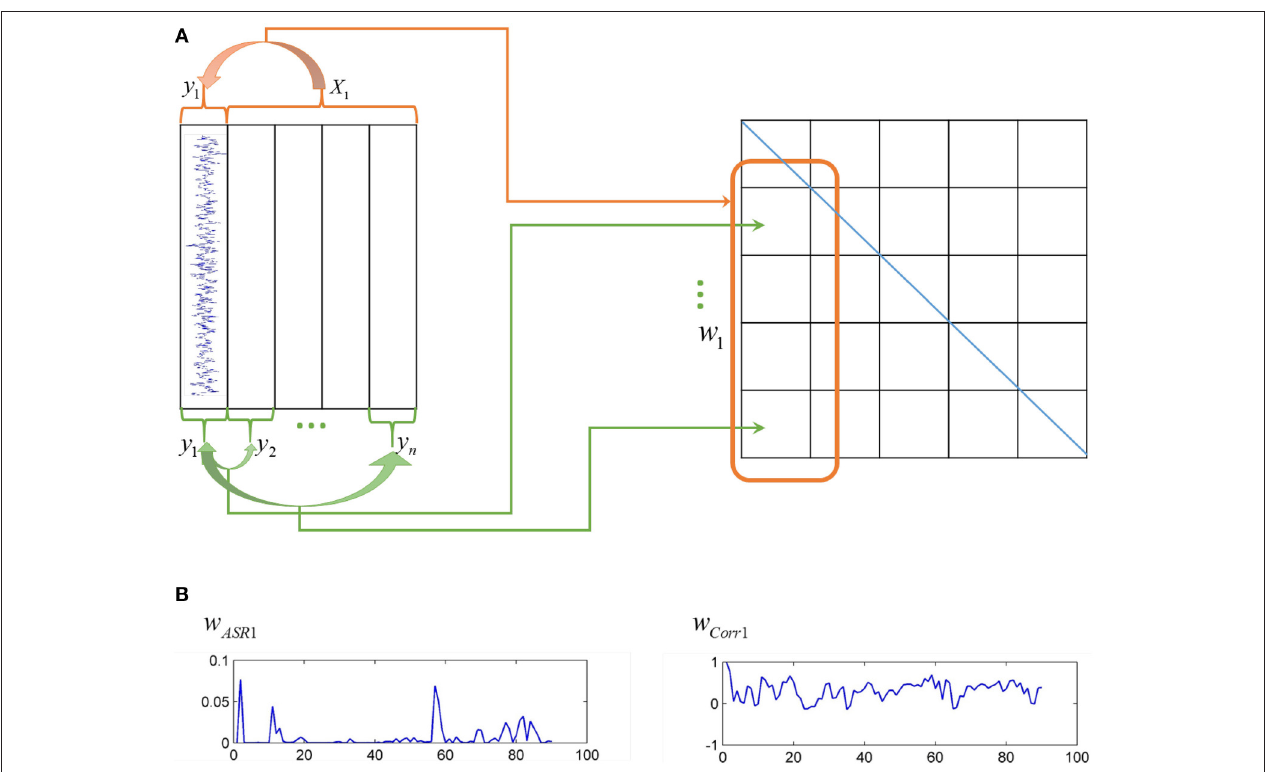
FIGURE 1 | Different ways of ASR and the Pearson correlation to compute association matrices. (A) On the left panel, each column represents time series of each node, while on the right panel, each grid represents an element of an association matrix. The Pearson correlation computes the association between pairwise nodes as shown by the green arrows, while ASR considers the association between one node and all other nodes simultaneously as shown by the red arrow. (B) The left panel is an illustration of one typical column of the association matrix (i.e., the association of one node with all other nodes) derived by ASR, while the right panel derived by the Pearson